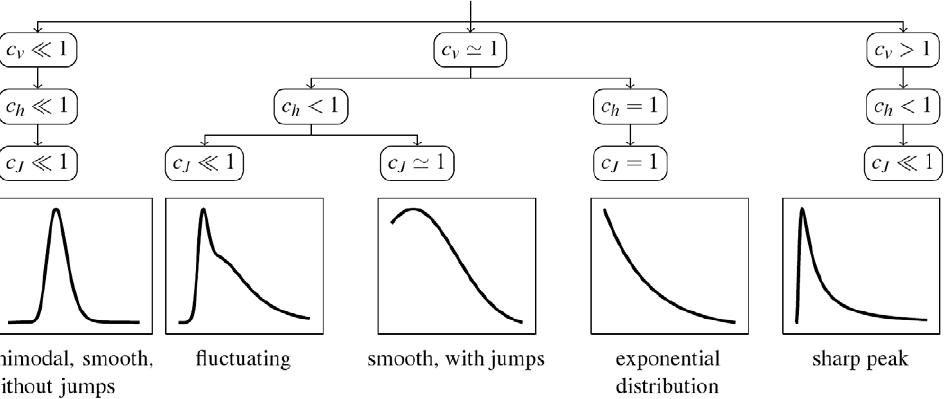
Figure 2. Illustration of a classification tree of probability densities based on typical values of the dispersion measures. Note, that not all combinations of values of c v , c h , c J can appear. Selected identification signs or examples of corresponding distributions, which are typical but not necessarily comprehensive, are written bellow the corresponding illustrative plots of densities.